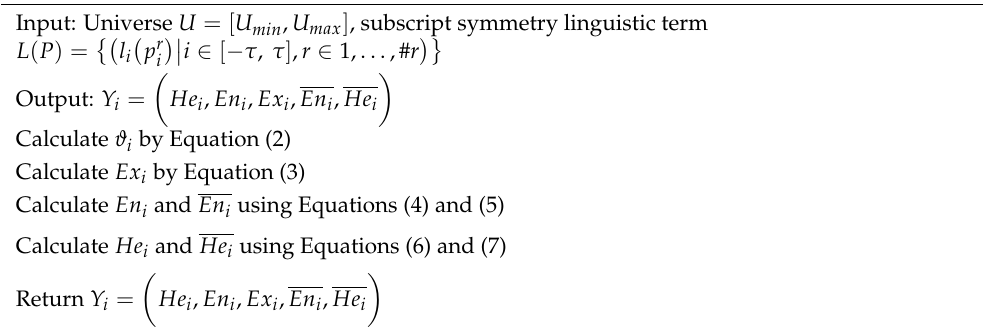
Algorithm 1: Convert Linguistic Variables to